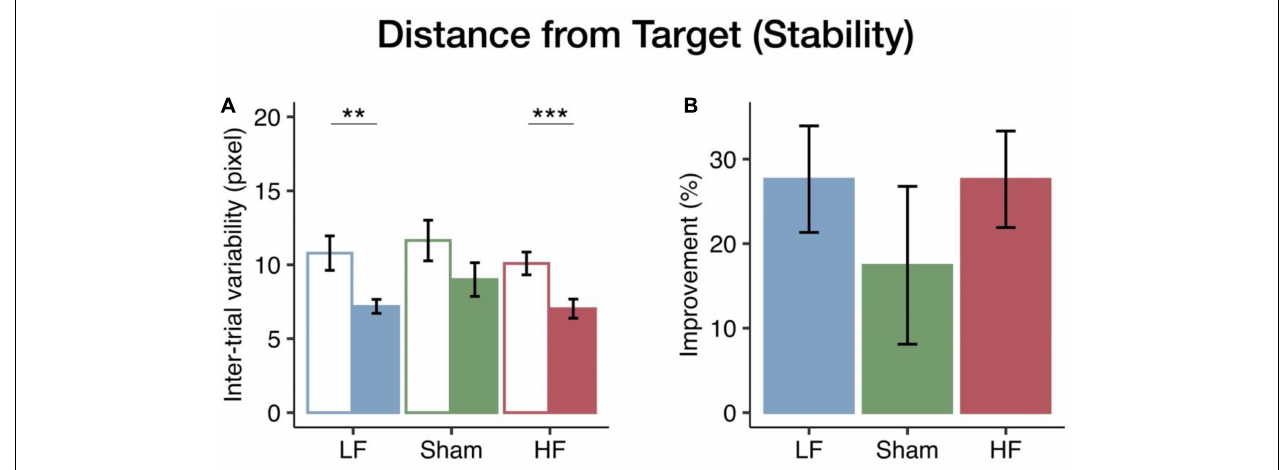
FIGURE 3 | Changes in visuomotor stability in the distance from target among the three rTMS groups. (A) The bars (blue, LF; green, sham; red, HF) represent the mean intertrial variability in the pre-test (empty bar) and post-test (solid bar). Both the HF and LF groups had greater decreases in intertrial variability than the sham group. (B) The bars represent the mean improvements in the intertrial variability. Error bars indicate the standard error of the mean. Bonferroni correction was applied to all p -values (** p < 0.01; *** p <